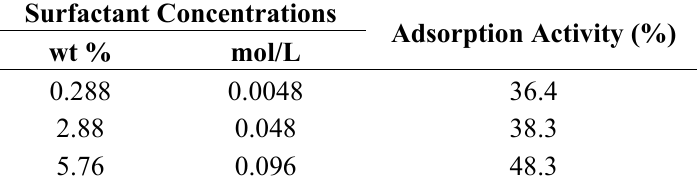
Table 1. Adsorption of the LPMQA prepared surfactants on the surface of the dispersed magnetite particle (10 wt